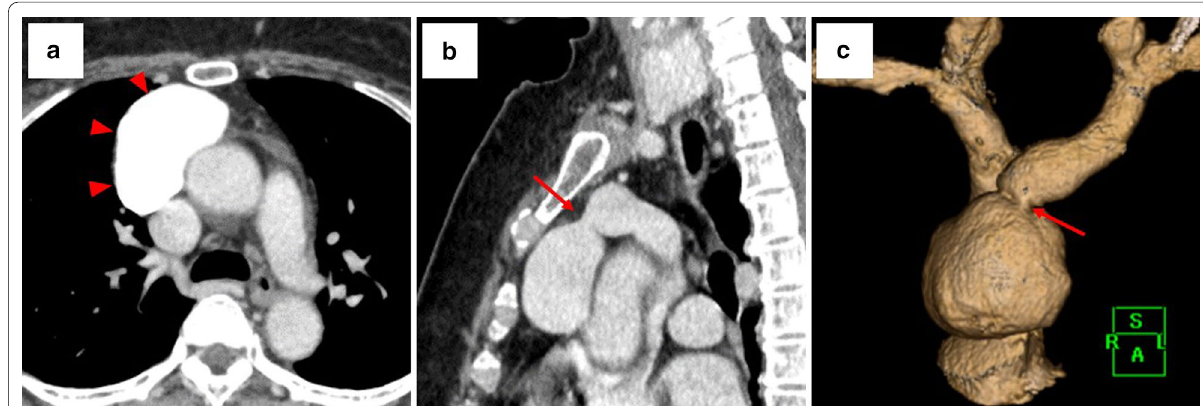
Fig. 1 The inside of the aneurysm showed uniform uptake of contrast material and there were no areas of poor contrast that were suggestive of thrombosis ( a ). The aneurysm showed the same absorption value as the brachiocephalic veins, and its neck was 8 mm in diameter ( b , c